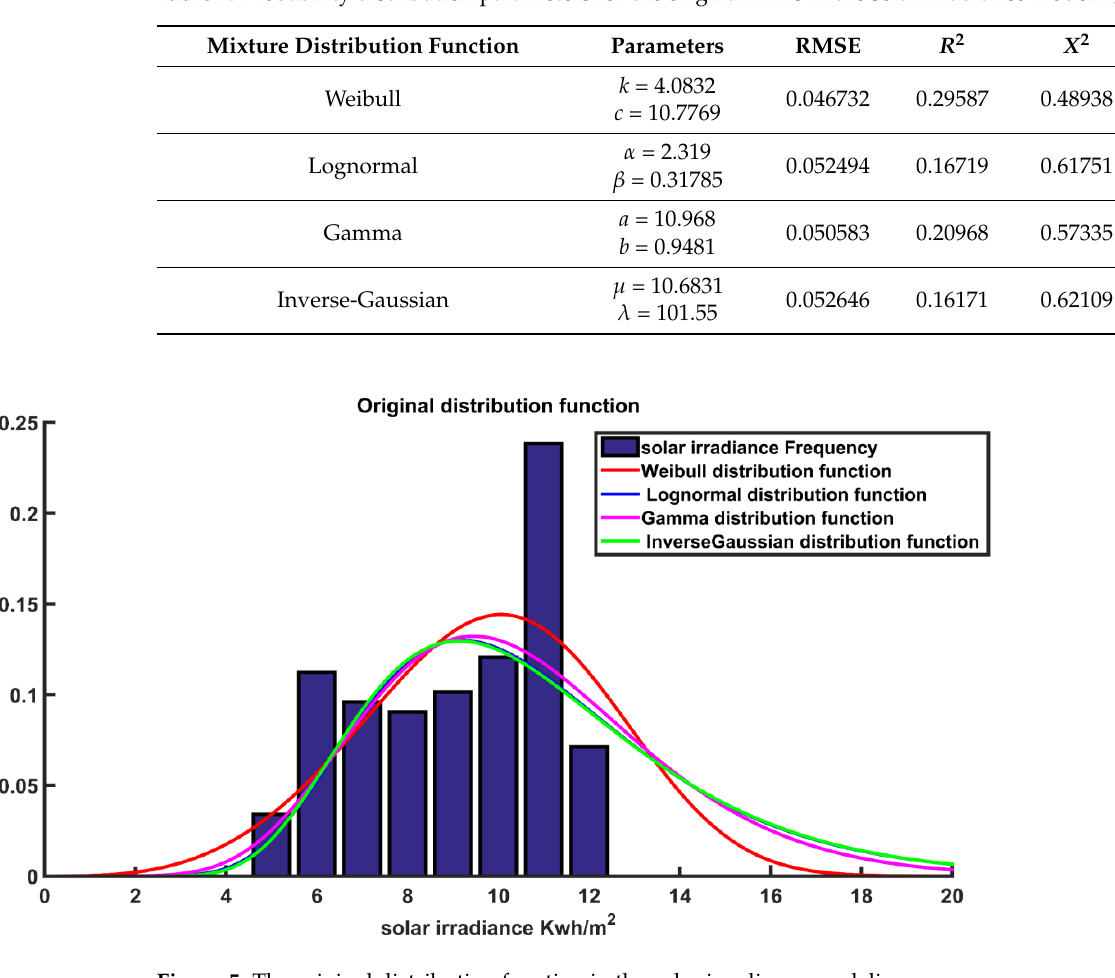
Table 5. Probability distribution parameters for the two-component mixtures of PDFs in the solar irradiance modeling.